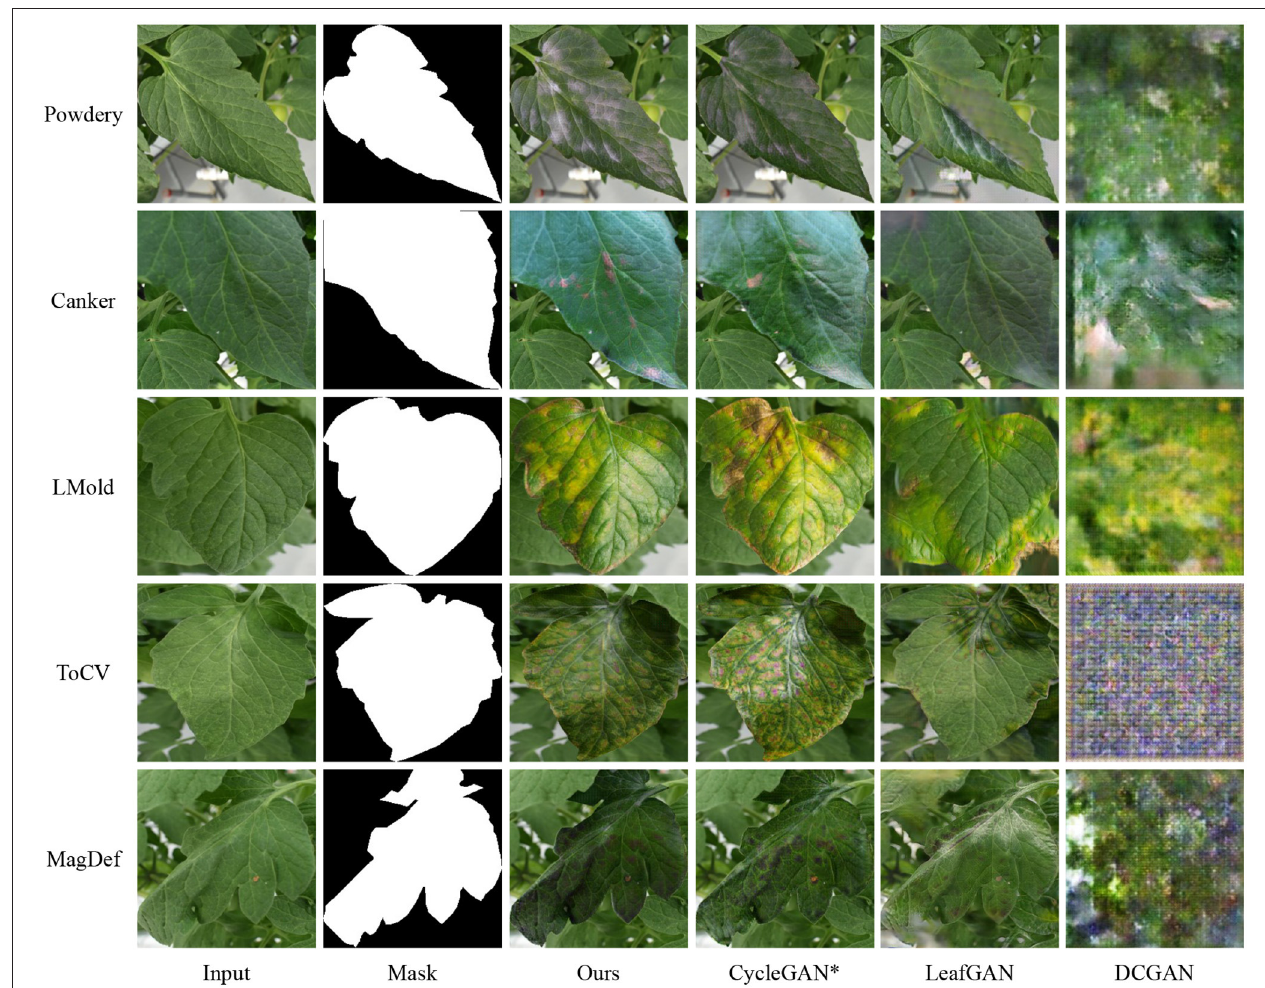
FIGURE 7 | Qualitative results of different algorithms to do image translation for image classification.